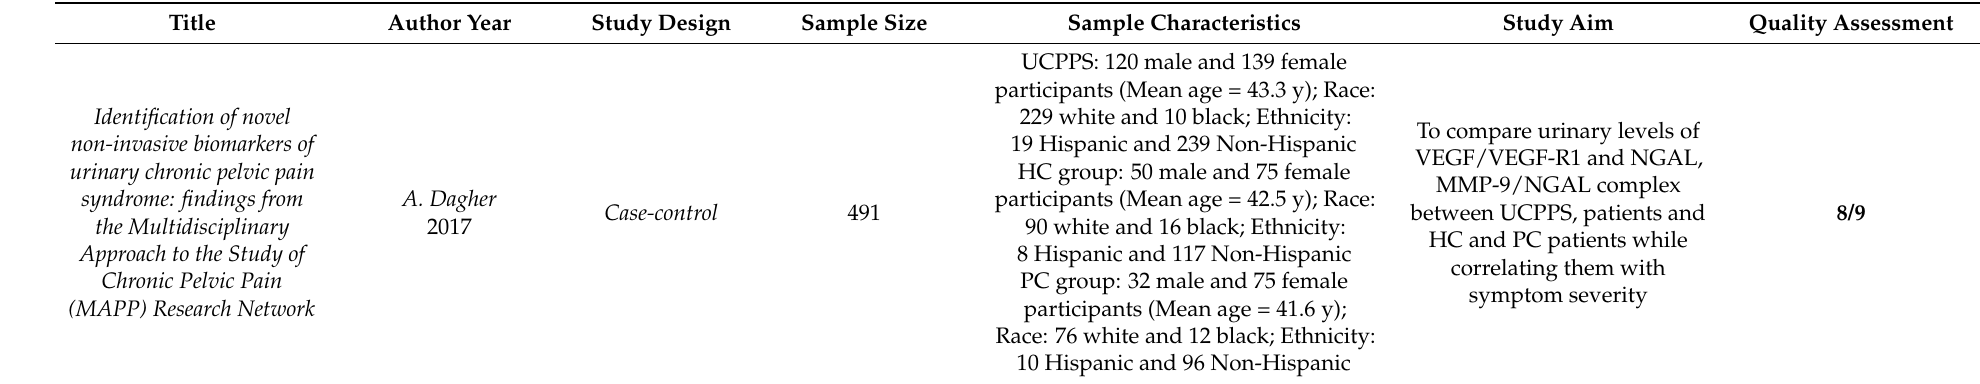
Table A4. Table with studies’ characteristics (title, first author, publication year, sample size, sample characteristics, study aim and quality